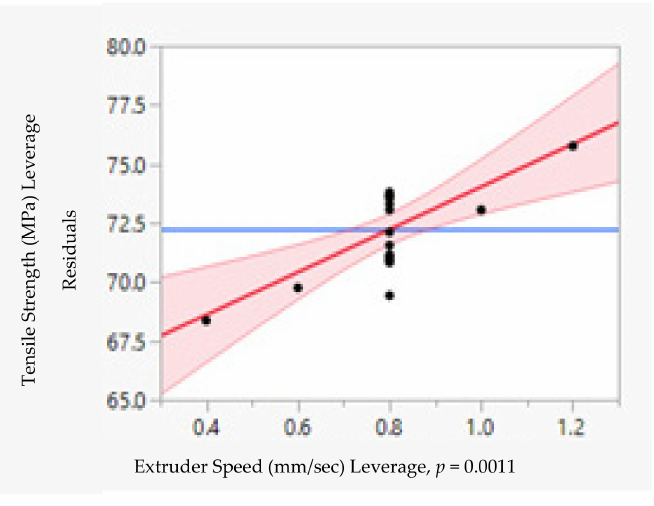
Figure 16. Tensile Strength vs. Shell Thickness. From the leverage plots, the p -value for each process parameters was obtained to determine their significance. The extruder temperature, extruder speed, and shell thickness highly influenced the tensile strength of the CFRPLA specimen while layer thickness had less impact on the tensile